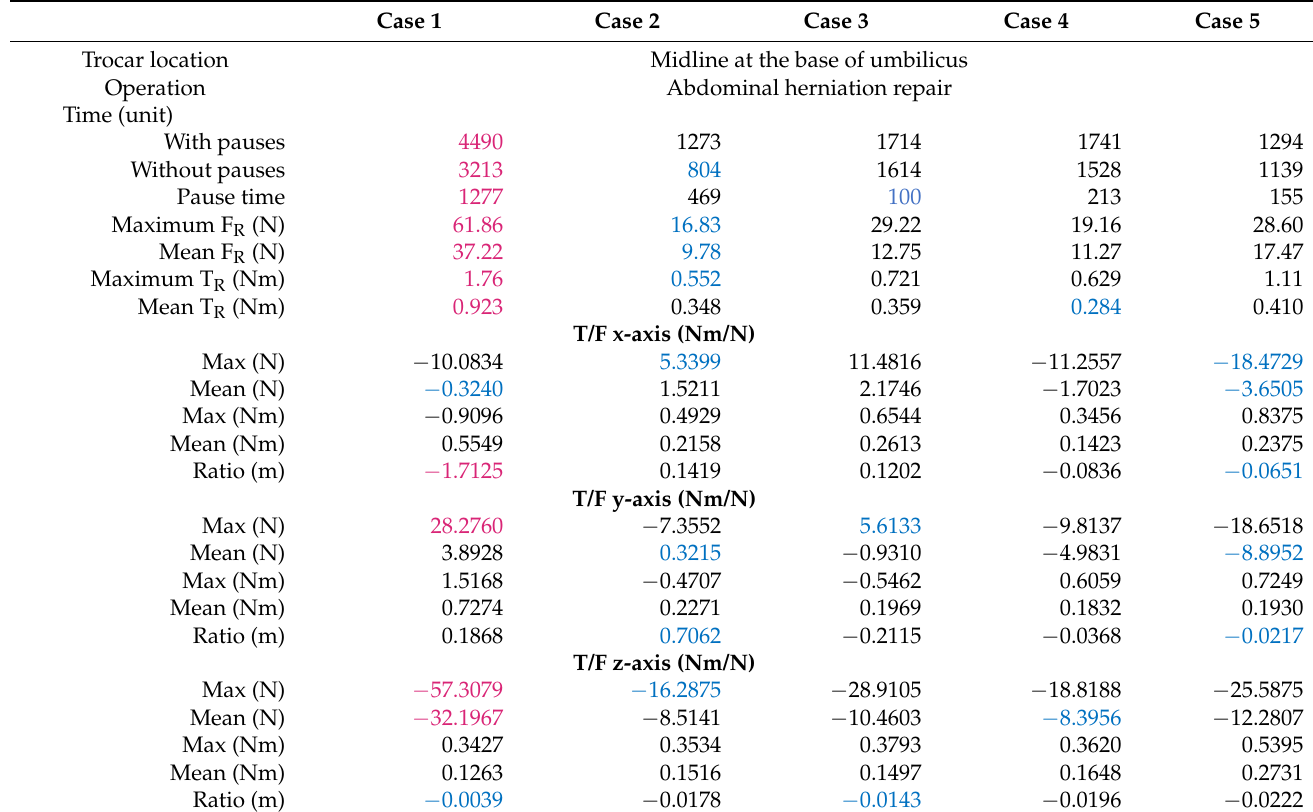
Table 2. Shows summary of data collected from force–torque sensor measurement during primary tro- car insertion for abdominal hernia cases at Department of Surgery, Faculty of Medicine, Ramathibodi Hospital. Red-pink text: maximum value of the row. Blue text: minimum value of the